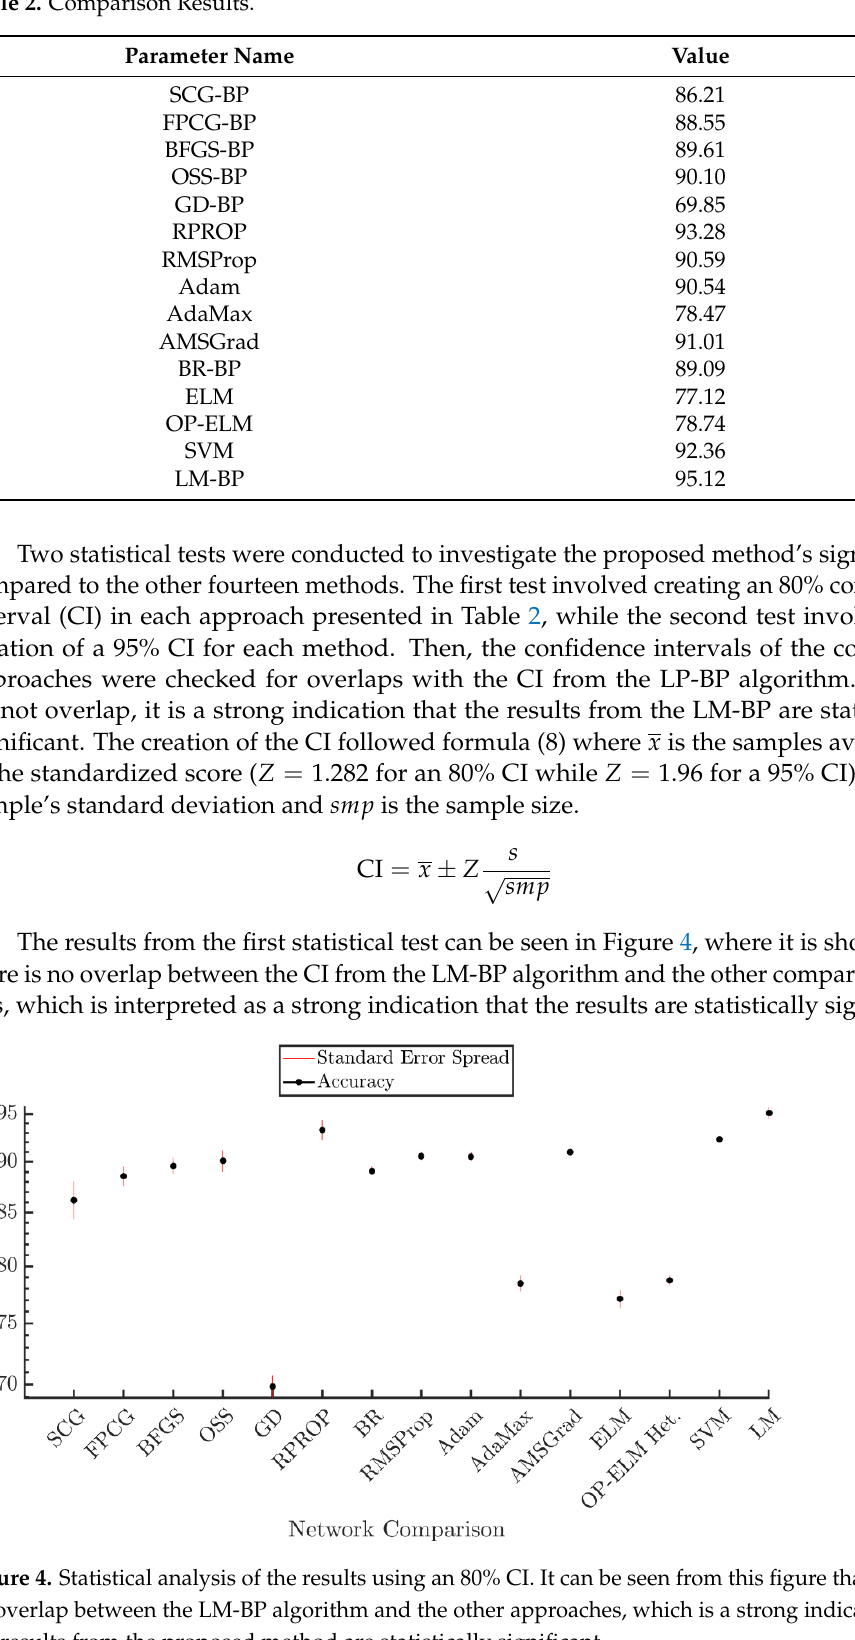
Table 2. Comparison Results.